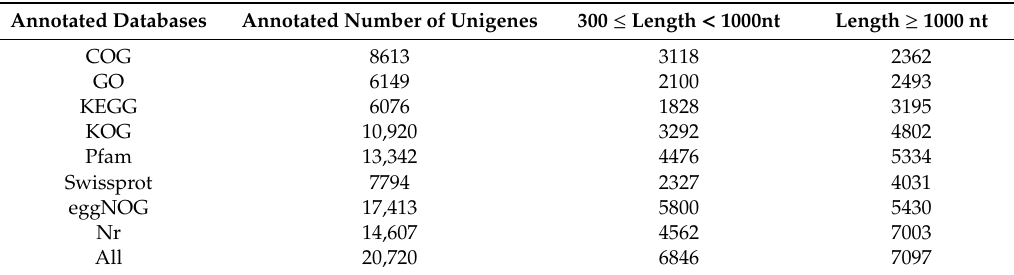
Table 2. Summary of the statistics for the annotation of unigenes of T. pisiformis . Annotated